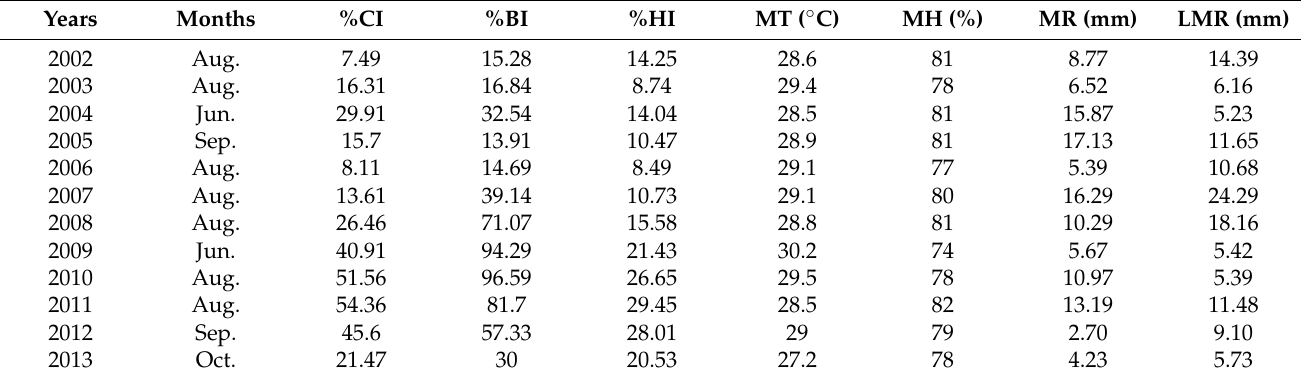
Table 1. Vector indices and climatic variables for specific months (2002–2013) in the city of Dhaka, Bangladesh.